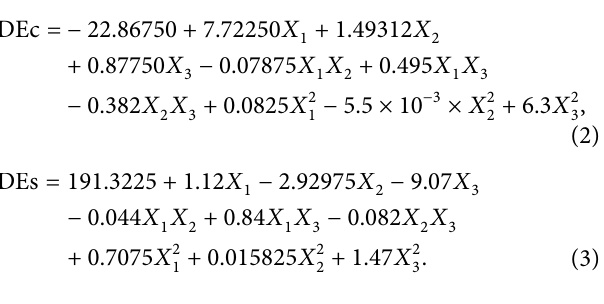
Figure 2: Comparison between predicted and observed